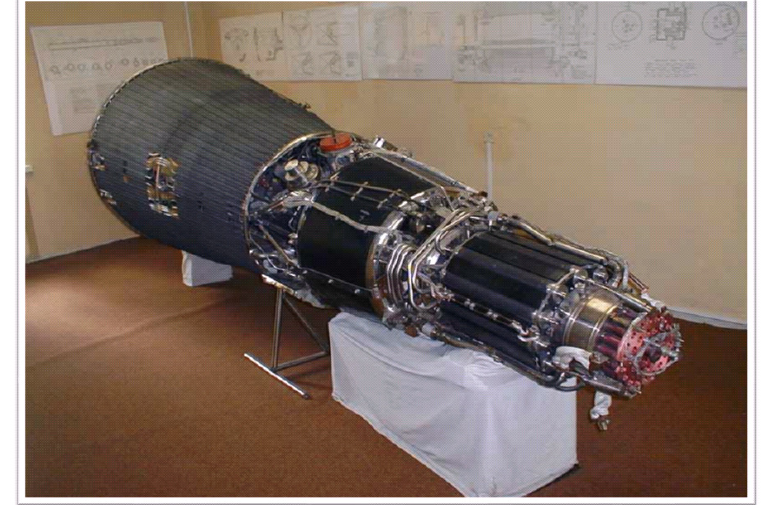
Figure 9: Nuclear powerplant with thermionic reactors for space applications "Topaz".